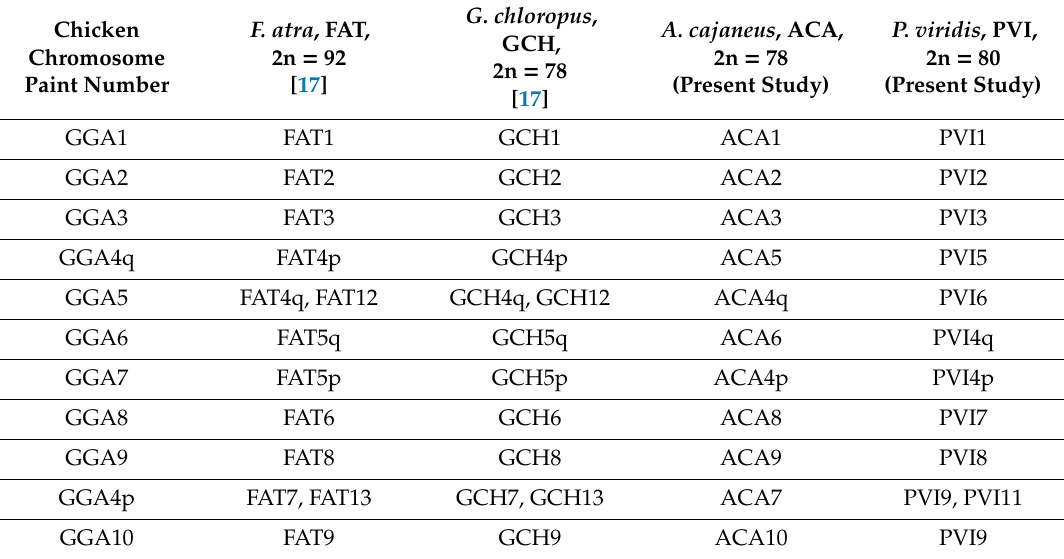
Figure 3. Chromosome painting of G. gallus in Psophia viridis . The large pink fluorescence area on the 148 Figure 3. Representative examples of chromosome painting using macrochromosomes of G. gallus in top left corner of the figure (C) is a signal of regions in the nucleus that were hybridized by the probe 149 Psophia viridis : GGA2 ( A ), GGA3 ( B ), GGA5 ( C ) and GGA 9 ( D ). The large pink fluorescence area on used (GGA5). 150 the top left corner of the ( C ) represent signals produced by the probes in interphase nucleus. Table 1. Chromosomal homologies among Gruiformes species and Gallus gallus